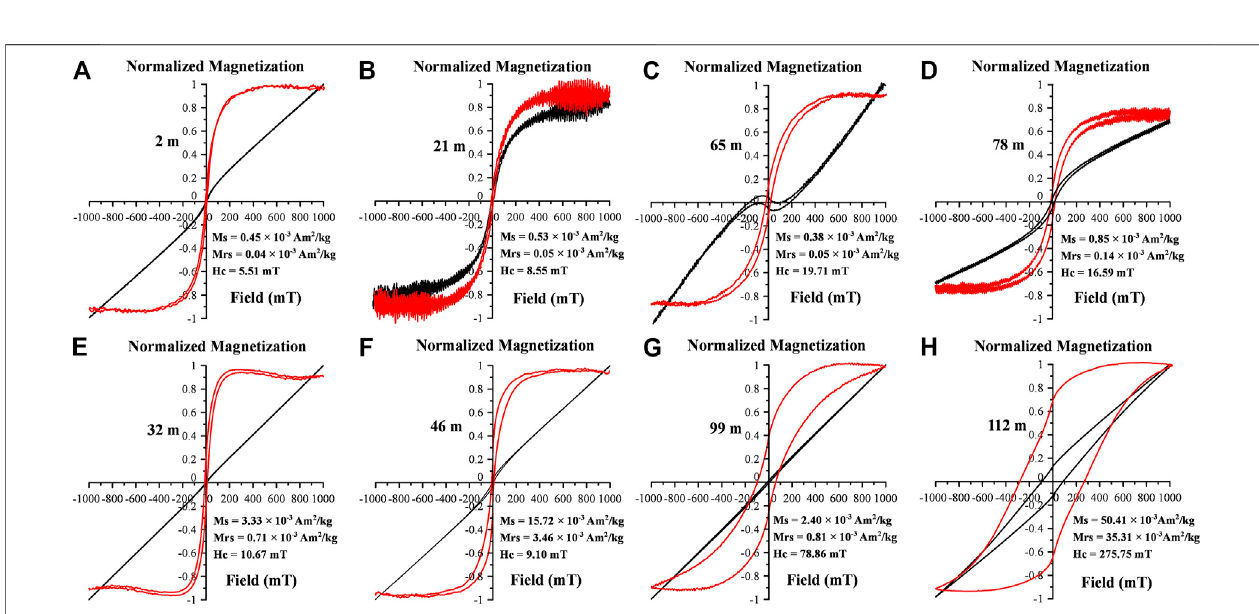
FIGURE6| Representativehysteresis loopsofthesamplesatvarious horizonsofthePalpa section. Theloopsfromsampleswithalow χ valueareshown in (A – D) and a high χ value in (E – H) . Note: Black and red lines indicate the curves before and after paramagnetism correction.